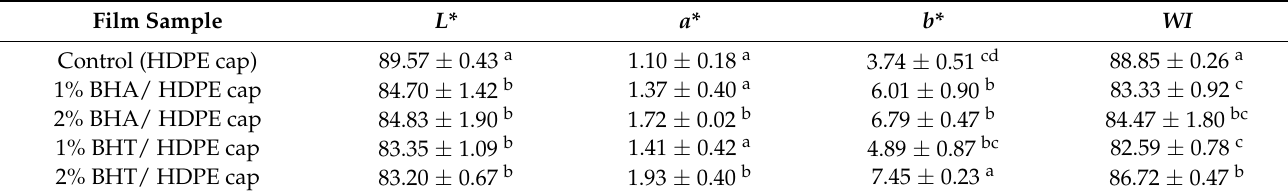
Table 3. The color of antioxidant active plastic bottle caps (mean ± SD, n =